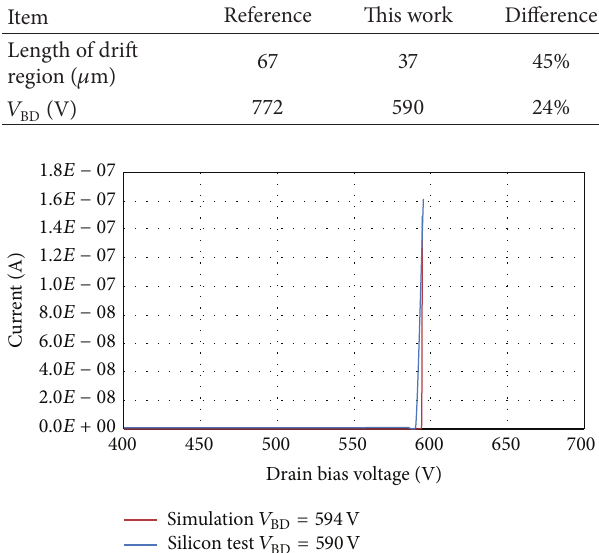
Figure 9: Breakdown voltage comparison of simulation and silicon data.